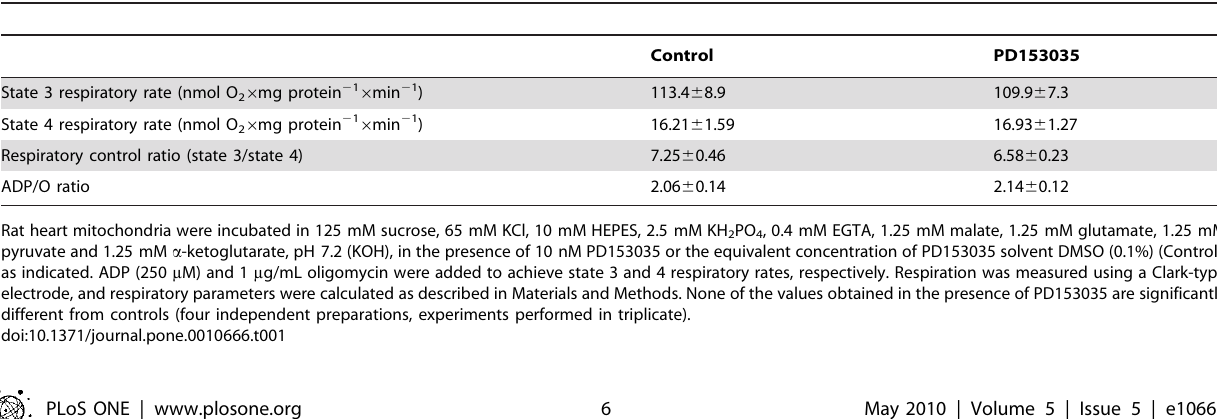
Table 1. PD153035 does not change mitochondrial respiratory parameters.